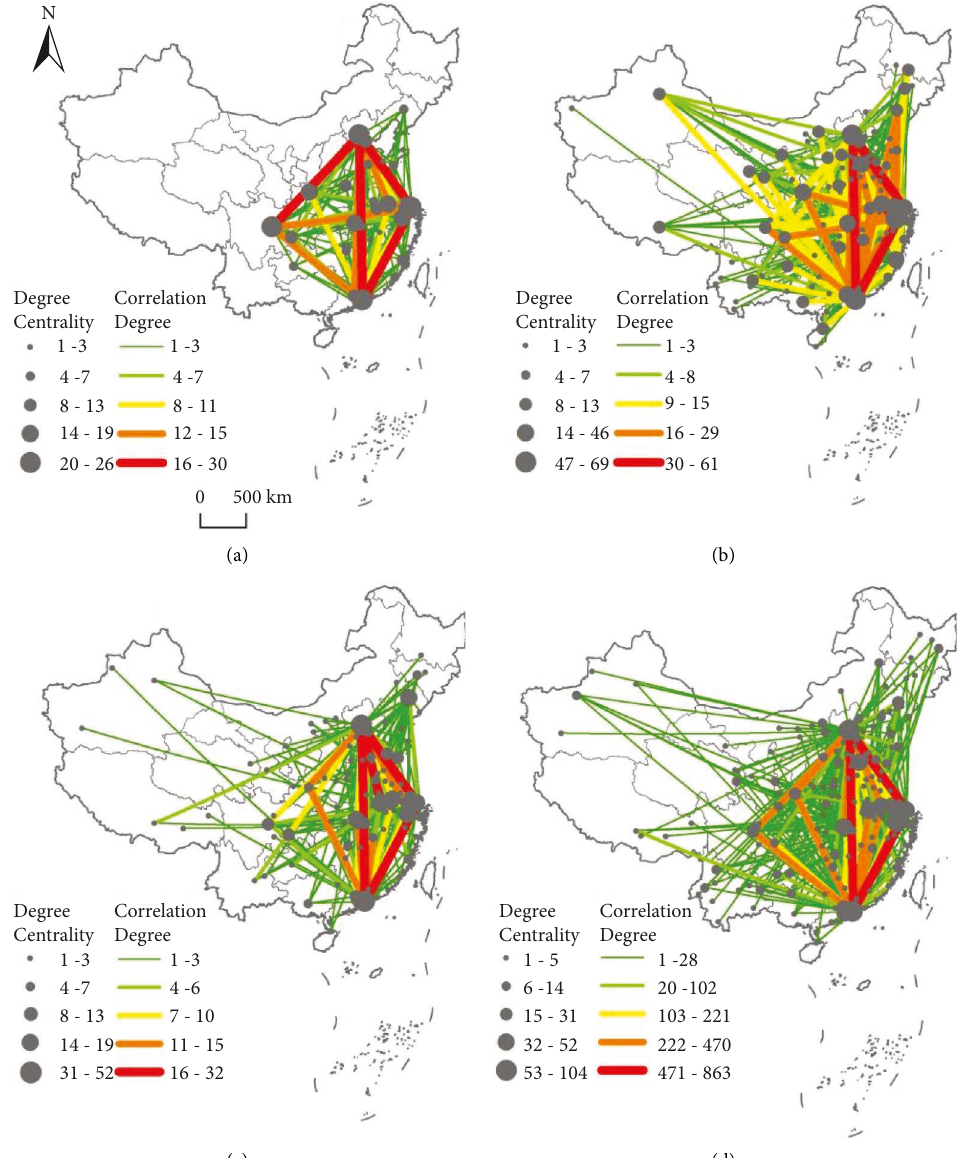
Figure 2: Hierarchical divisions and spatial distribution of degree centrality and relevance of the cities for each network. (a) R & D network. (b) Sales network. (c) Investment network. (d) Comprehensive network.